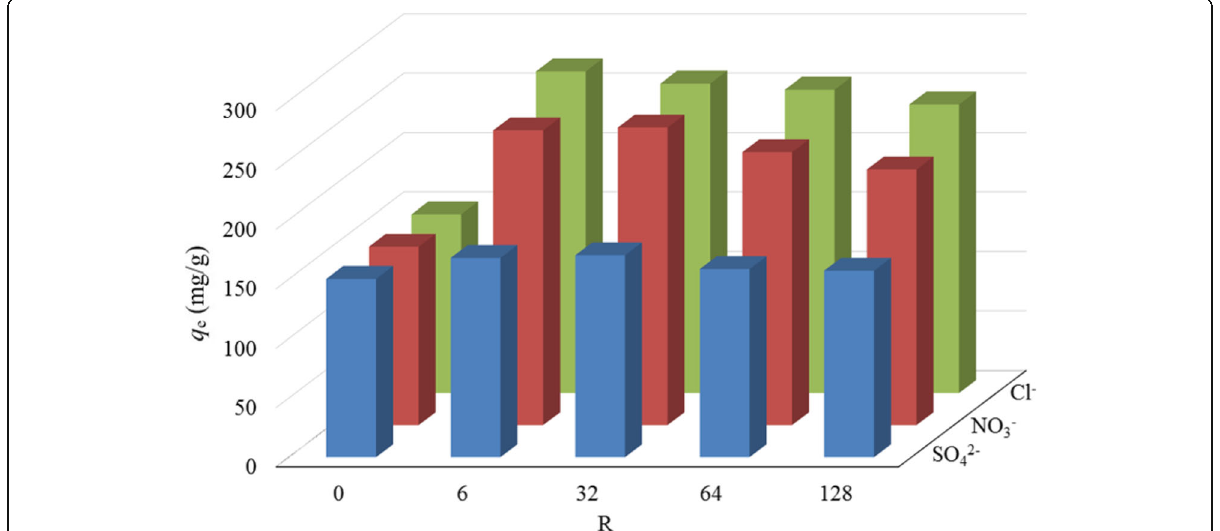
Fig. 5 The effect of competitive ions on Cr(VI) remove of PPMs. (Condition: PPMs 0.2 mg, initial Cr(VI) = 20 mg/L, 10